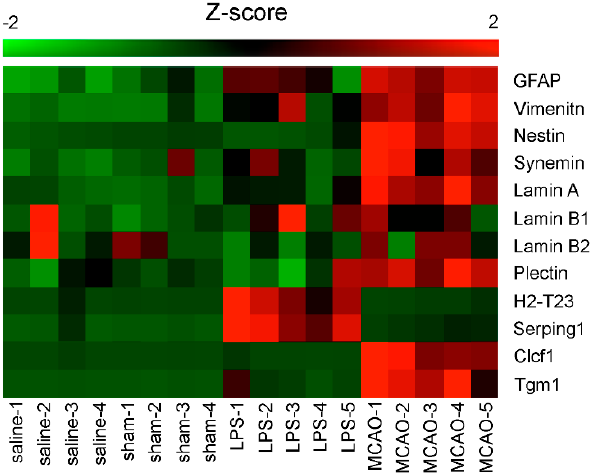
Figure 2. Expression profile of intermediate filament and cytolinker genes in A1 and A2 reactive astrocytes. Microarray data provided in [98] are converted to Z scores and expressed as a heatmap. Saline-1 to -4 are controls of LPS treatments (A1 reactive astrocytes) and sham-1 to -4 are controls of MCAO (A2 reactive astrocytes), where LPS is Escherichia coli endotoxin O55:B55 and MCAO stands for transient ischaemia induced by occluding the middle cerebral artery. H2-T23 and Serping 1 are representative genes highly and selectively expressed in the A1 astrocyte subtype, whereas Clcf1 and Tgm 1 are specific for the A2 astrocyte subtype.